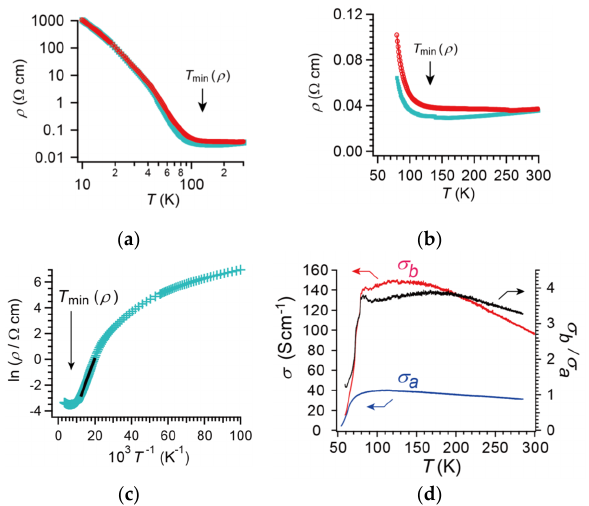
Figure 3. ( a ) Temperature dependence of electrical resistivity of α -STF 2 I 3 (10–300 K). Red; heating-process data, blue; cooling-process data; ( b ) An enlarged view of the higher temperature range; ( c ) Arrhenius plot of electrical resistivity of the same data (cooling process) in Figure 3a. For reference, the black line shows the best fitting line to the widest linear range (50–80 K), showing an apparent activation energy of ~0.034 eV. ( d ) Electrical conductivities along the a - ( σ a ) and the b -axes ( σ b ), and the anisotropy in the ab -plane σ b / σ a